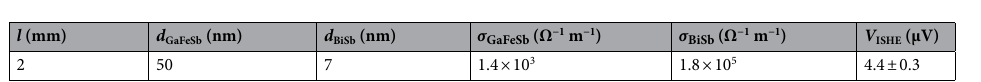
Figure 4. ( a ) Temperature dependence of the resistivity of the BiSb (7 nm)/(Ga,Fe)Sb (50 nm) heterostructure (sample A, red open circles) and the 50 nm-thick (Ga,Fe)Sb reference (sample B, black open circles). ( b ) Perpendicular magnetic field μ 0 H dependence of the anomalous Hall resistance ( R AHE ) of sample B measured 0 at various temperatures. ( c ) Saturation values ( R AHE ) of R AHE as a function of temperature in sample B. ( d ) In-plane magnetic field direction ( φ H ) dependence of the planar Hall resistance ( R PHE ) of sample B with the applied magnetic field of 50 mT, 80 mT, and 100 mT measured at 300 K. φ H is the angle of the in-plane magnetic field with respect to the [ 110 ] axis. ( e ) μ 0 H dependences of the voltage signal V (offset voltage V offset is subtracted) of sample A measured with 200 mW at various temperatures, ranging from 300 to 10 K, for θ H = 90°. The black dotted curves represent fittings which were used to derive the magnitude of the symmetric voltage ( V sym ) and antisymmetric voltage ( V asym ) components. ( f ) V sym and V asym of sample A as a function of temperature. Red solid circles and black solid squares represent V sym and V asym , respectively. The errors bars are standard deviations obtained from the fitting of the EMF peaks.